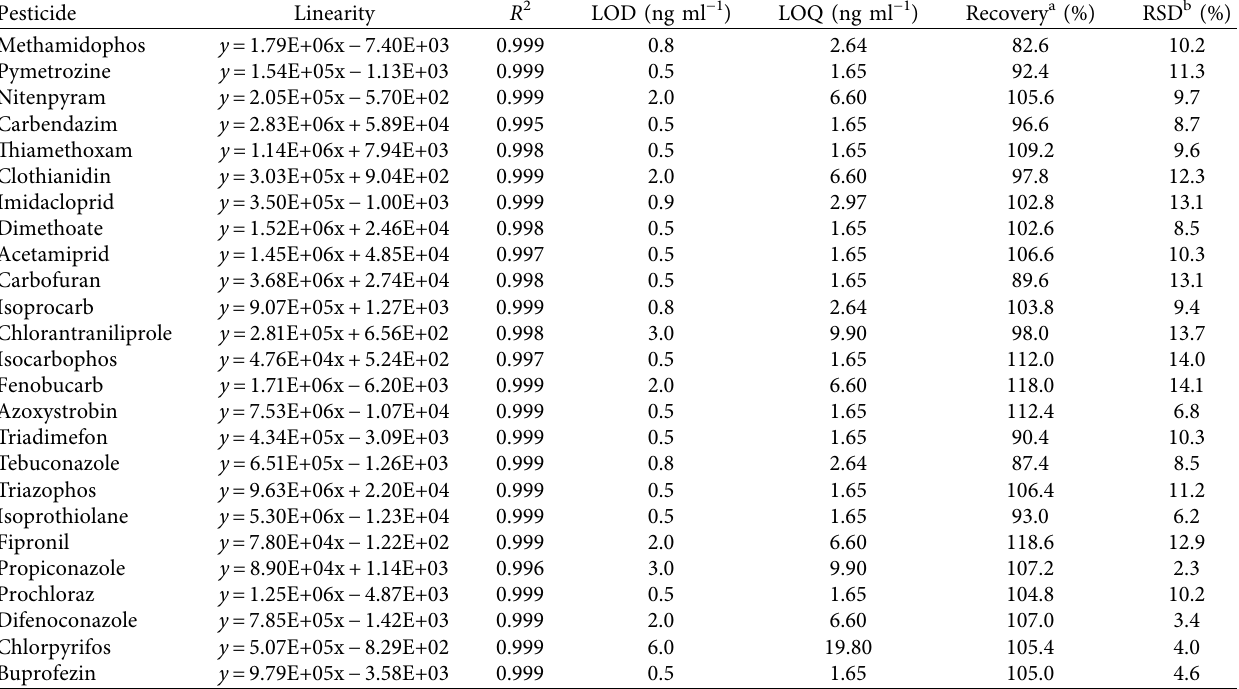
Table 1: The method validation parameters of the 25 pesticides analyzed in this study. Pesticide